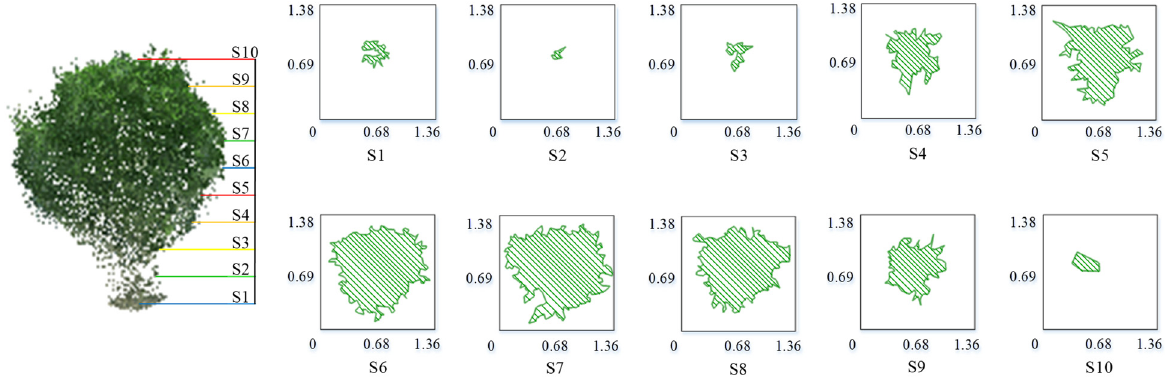
Figure 9. Schematic diagram of convex hull by slices algorithm.